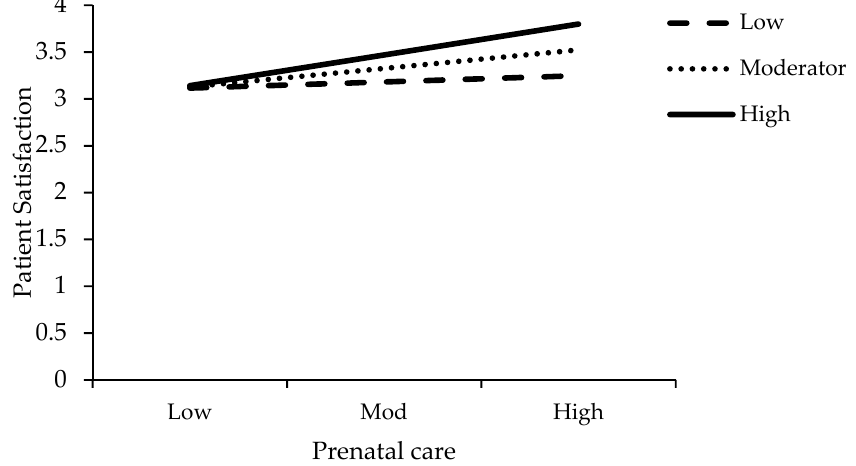
Figure 4. Interactive e ff ect of the prenatal care (PC) and PB on patient satisfaction.